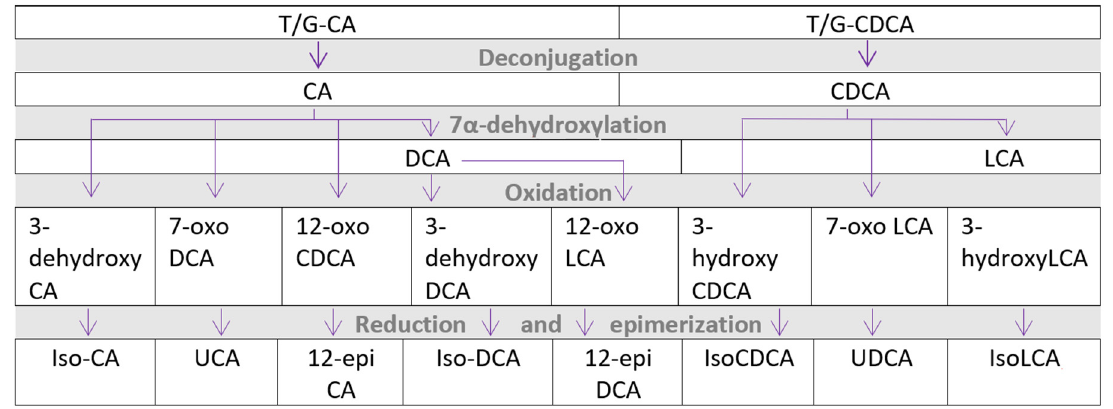
Figure 1. Microbial metabolism of bile acids to secondary and tertiary bile acids. CA—cholic acid,